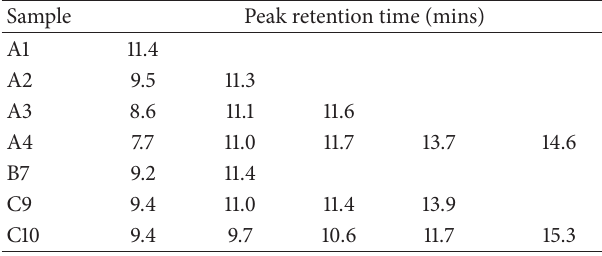
Table 2: Retention times of foam samples.